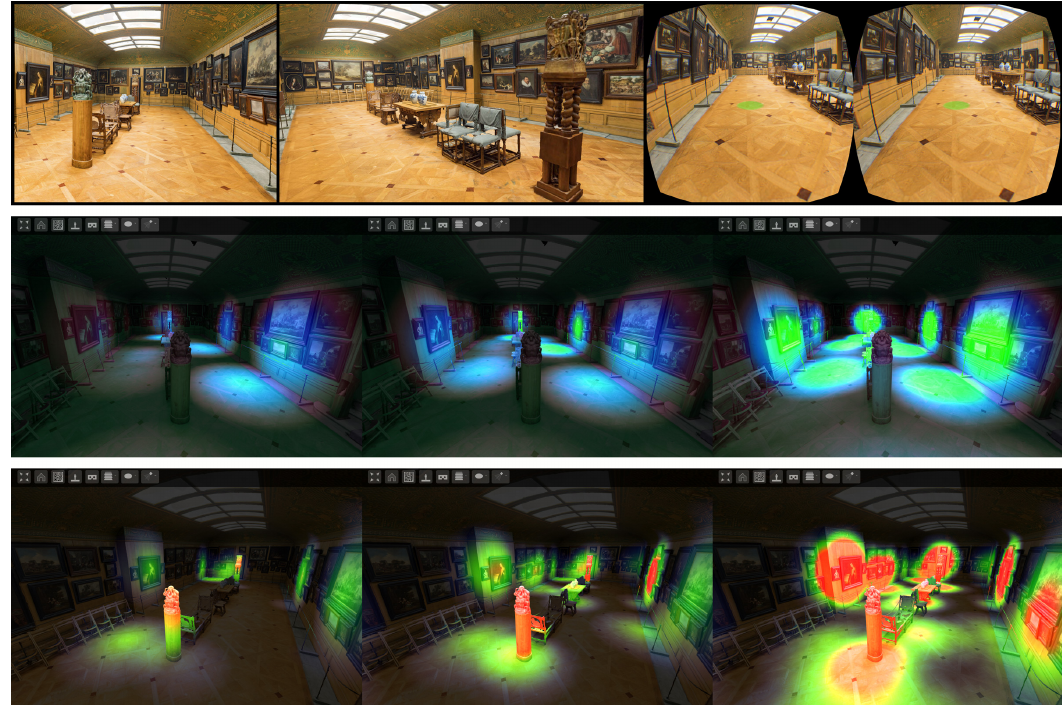
Figure 9. The sample interactive scene with immersive WebVR/XR visualization for students ( top ); interactive inspection of scene saliency: σ p (locomotion, middle ) and σ f (focus, bottom ) by remote analyst using a web browser (Chrome) while students are remotely exploring the virtual environment using head-mounted displays